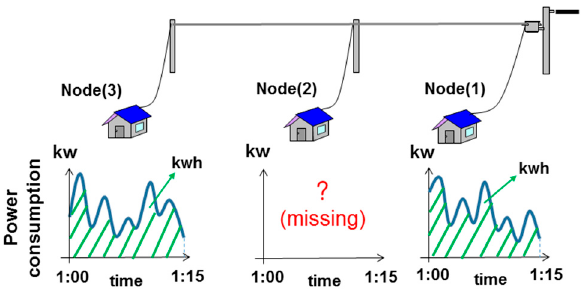
Figure 1. Example of a missing reading in a secondary network.